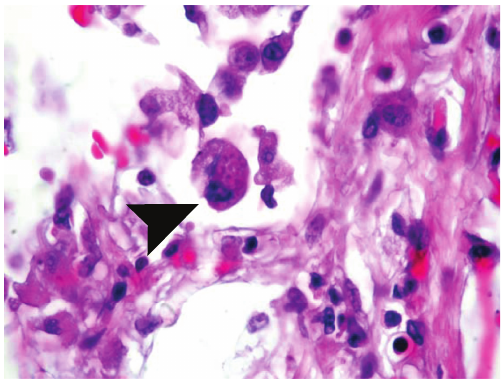
Figure 1: Cardiac section stained with hematoxylin/eosin showing interstitial and intra-alveolar infiltrates of lymphocytes and mono- cytes/macrophages containing Toxoplasma